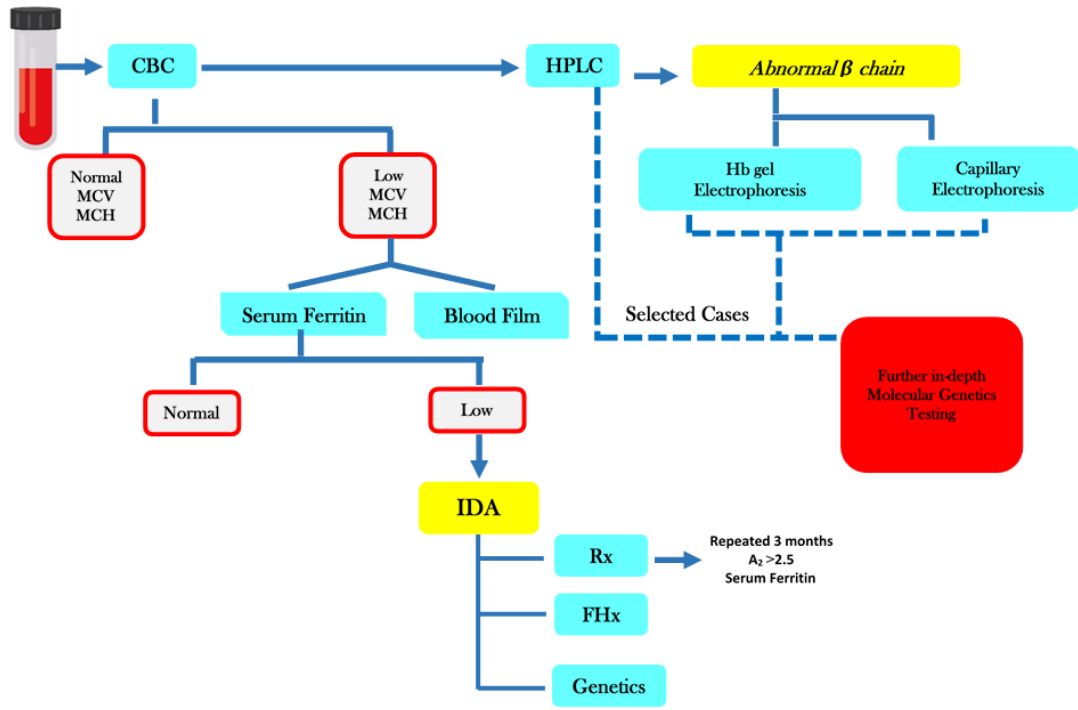
Figure 1. Diagnostic Cascade.